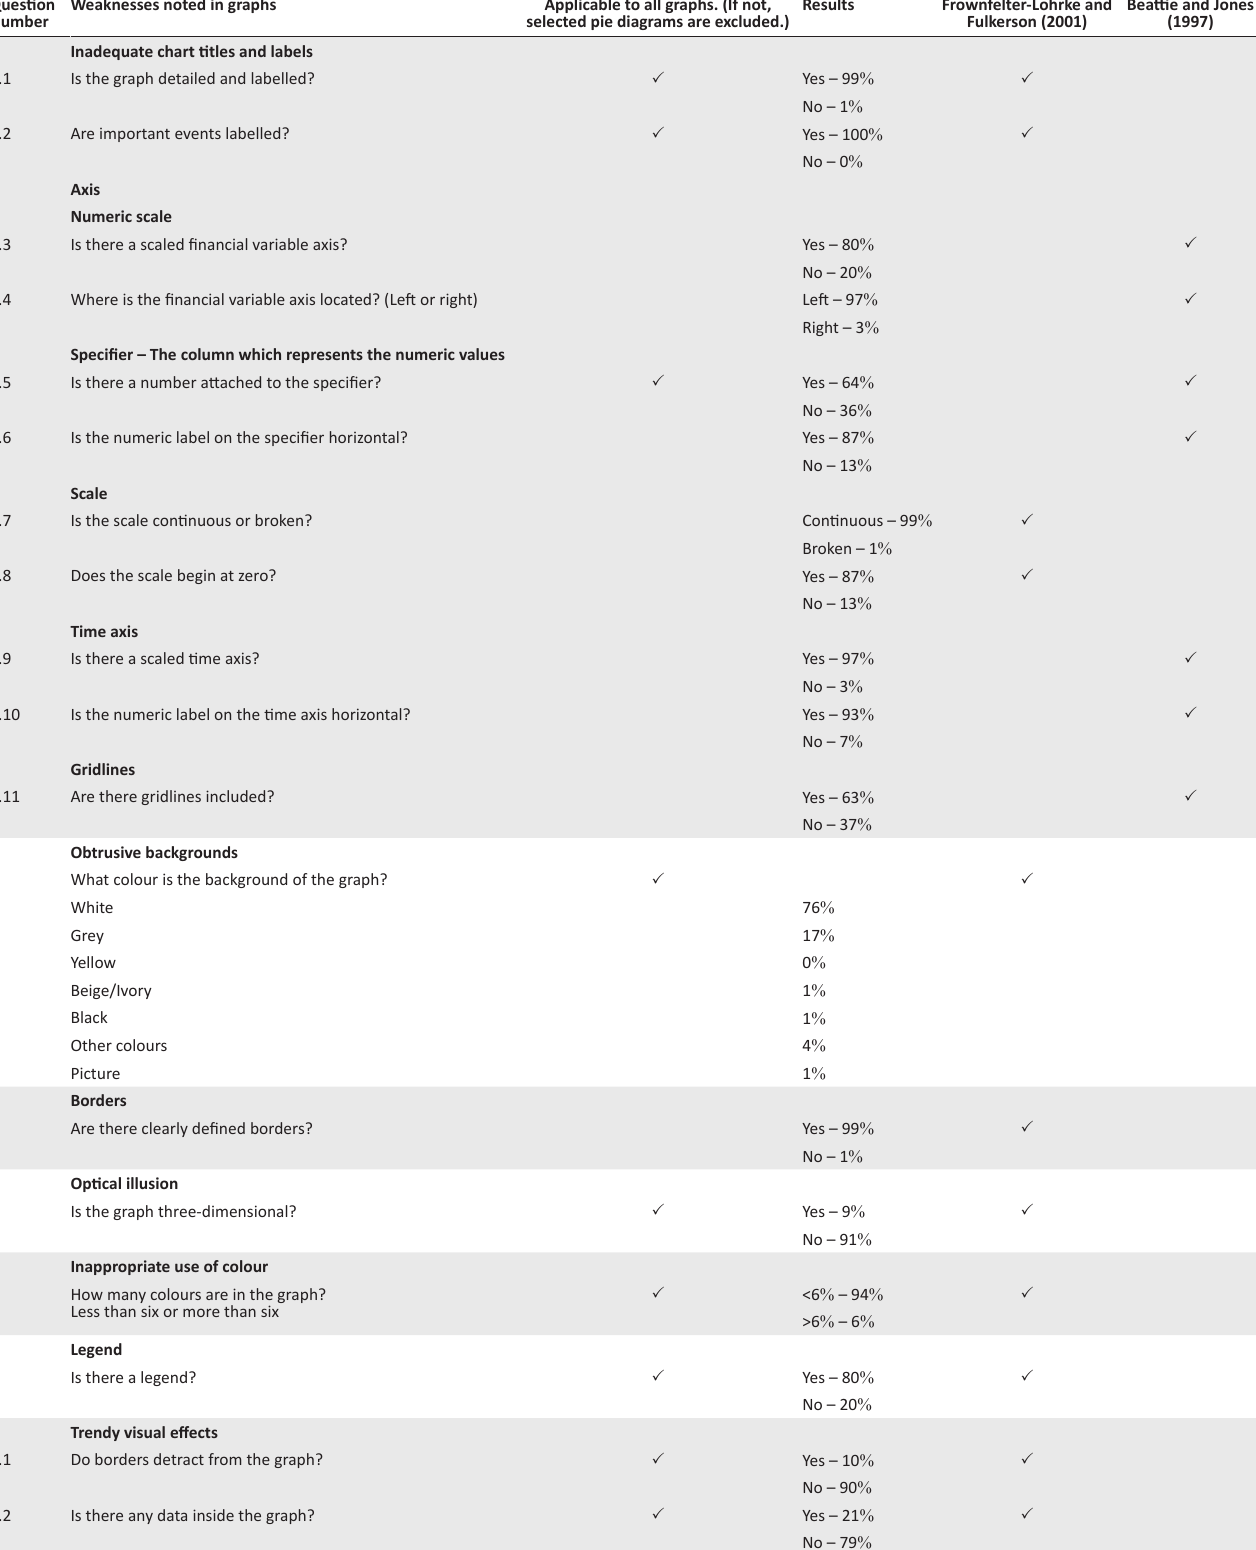
TABLE 1-A1: Checklist used to determine compliance with good graph guidelines. The questions were based on the study completed by Frownfelter-Lohrke and Fulkerson (2001); however additional questions were obtained from the study completed by Beattie and Jones (1997). The source of the question is noted below: Question Weaknesses noted in graphs Applicable to all graphs. (If not, Number selected pie diagrams are excluded.)